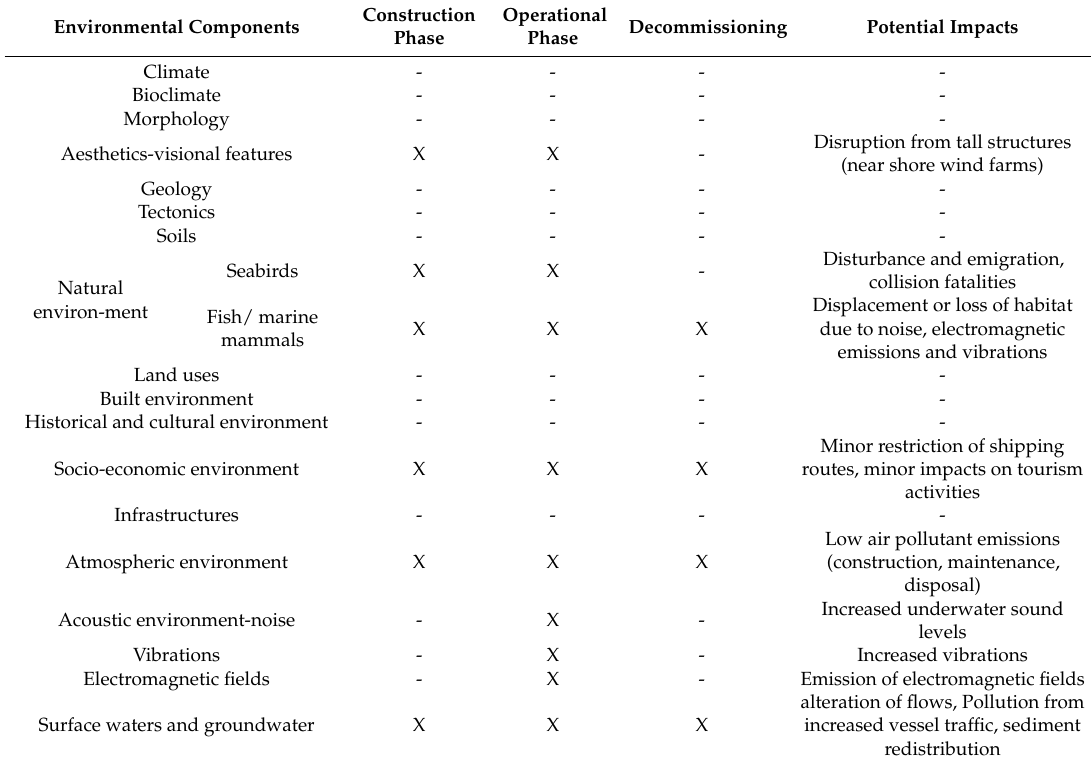
Table 5. Main environmental impacts associated with HOWiWaES developments.